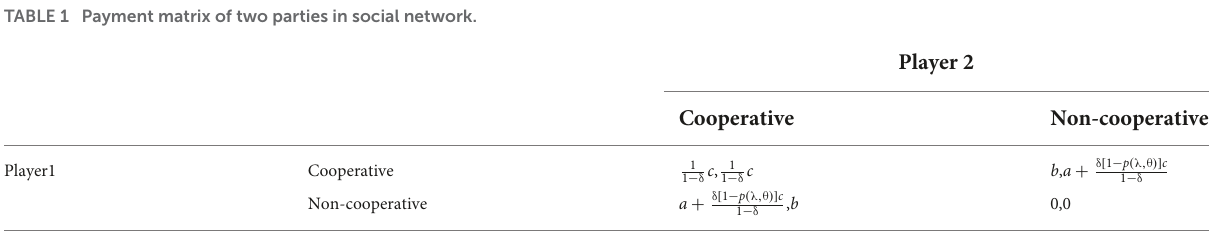
TABLE 1 Payment matrix of two parties in social